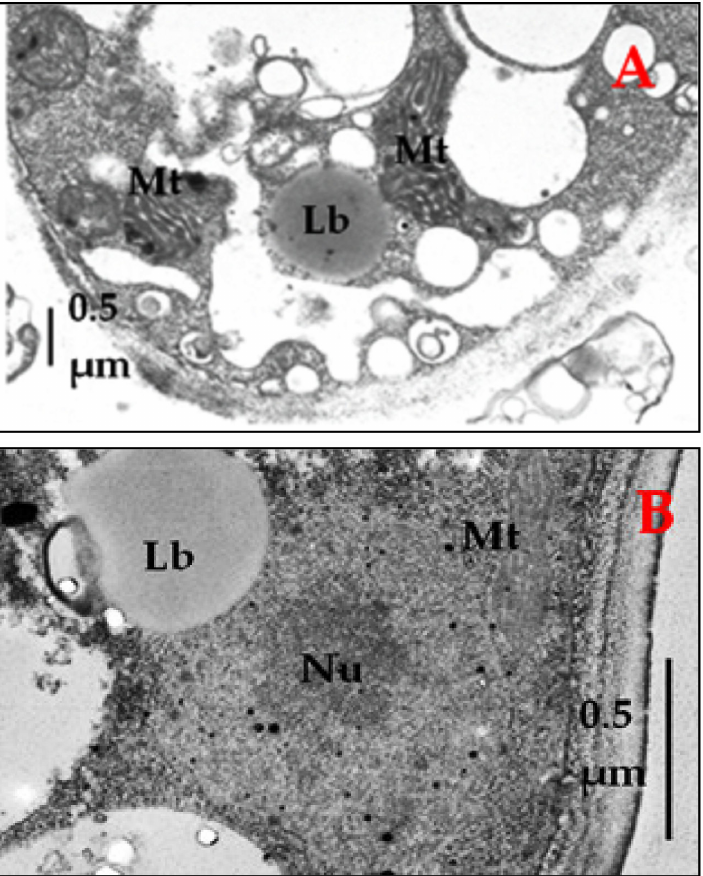
Figure 7. Image of E. magnusii yeast cells in the logarithmic ( A ) and early stationary growth phases ( B ). Nu—nucleus; Mt—mitochondria; Lb—lipid